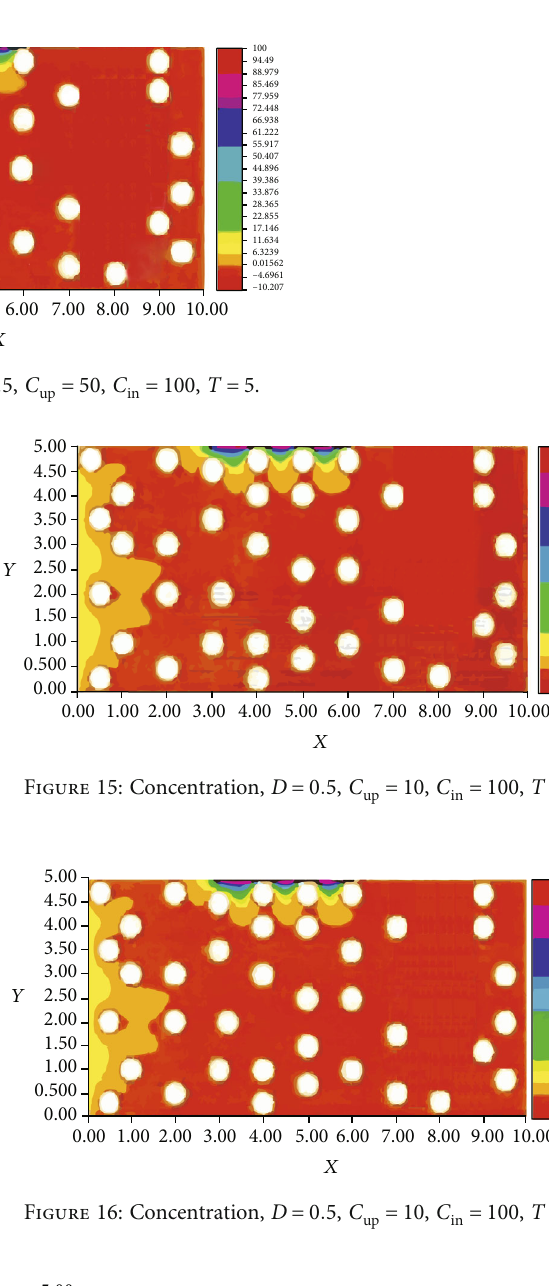
= 10 , C = 100 , T = 5 . up in